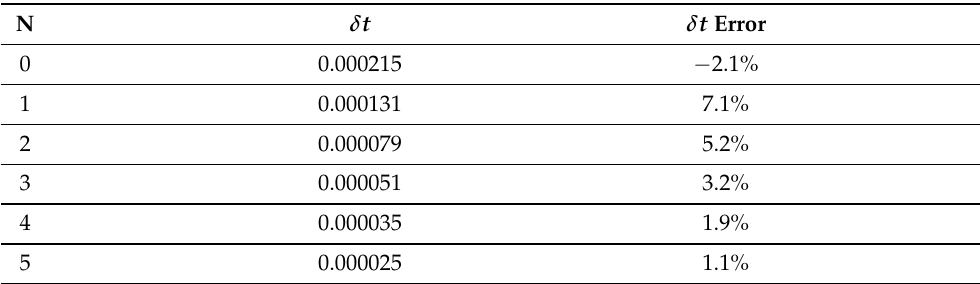
Table 10. Inner time step size δ t and relative δ t error for varying N , constant CFL number CFL ≈ 0.7 and ∆ x = 0.001.